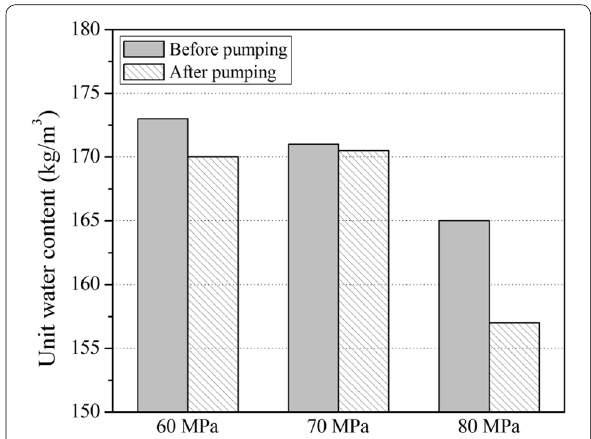
Fig. 13 Results of unit water before and after pumping (Ko et al.